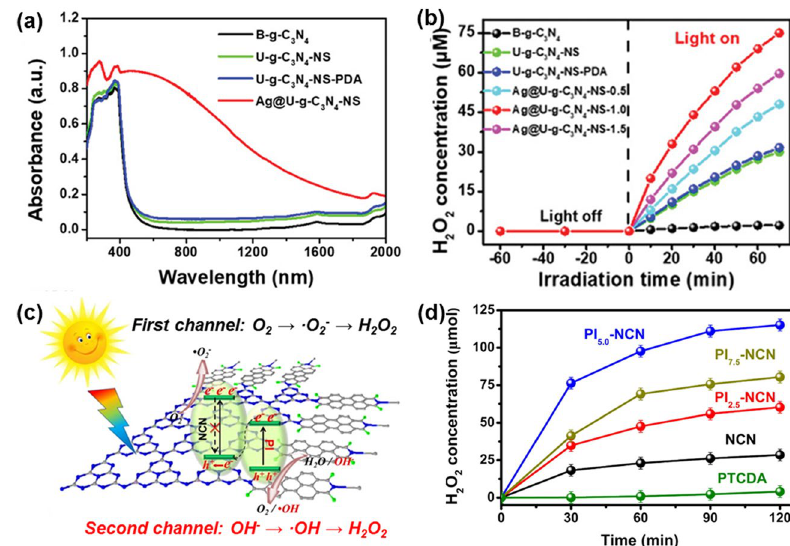
Fig. 4 a UV-DRS absorption spectra of different samples. b H 2 O 2 concentration of different catalysts. Reproduced with permission from Ref. [91]. Copyright 2019 Wiley–VCH Verlag GmbH & Co. KGaA, Weinheim. c Proposed mechanism of different sites on all-solid-state Z-scheme heterojunctions for photocatalytic production of H 2 O 2 . d Concentration of generated H 2 O 2 in NCN and PIx-NCN systems. Reproduced with per- mission from Ref. [97]. Copyright 2017